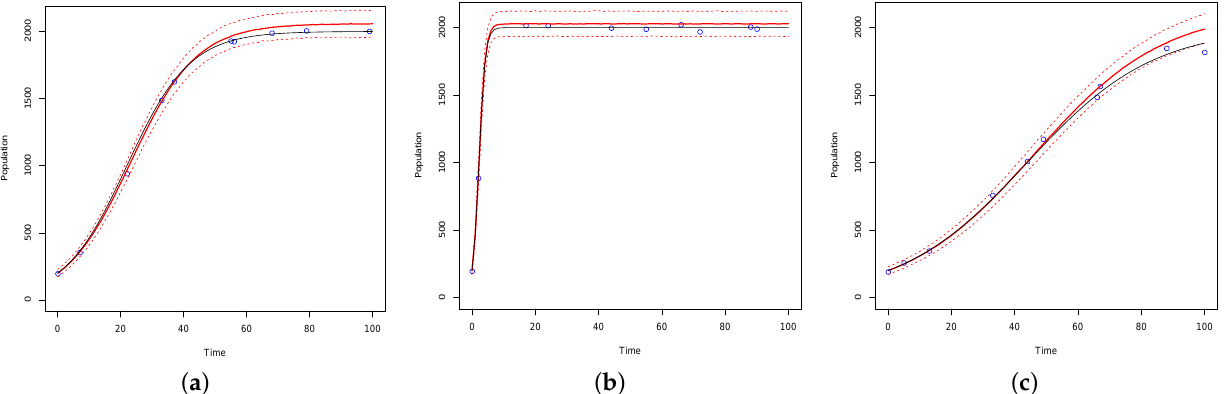
Figure 6. 10,000 MCMC samples are used to simulate I-optimal designs for ( a ) normal, ( b ) fast and ( c ) slow growth models. All models are simulated across 100 time points with a carrying capacity of 2000. The ground truth models are plotted in black. The optimal design points are plotted in blue and fit by a solid red curve, where the 2.5% and 97.5% quantiles of the predicted values are plotted as red dotted